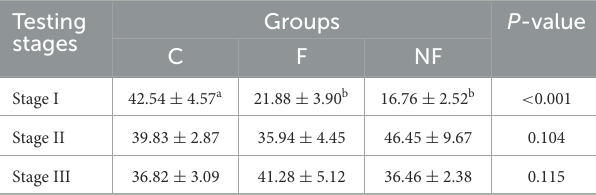
TABLE 6 Effects of non-fasting molting on liver weight of laying